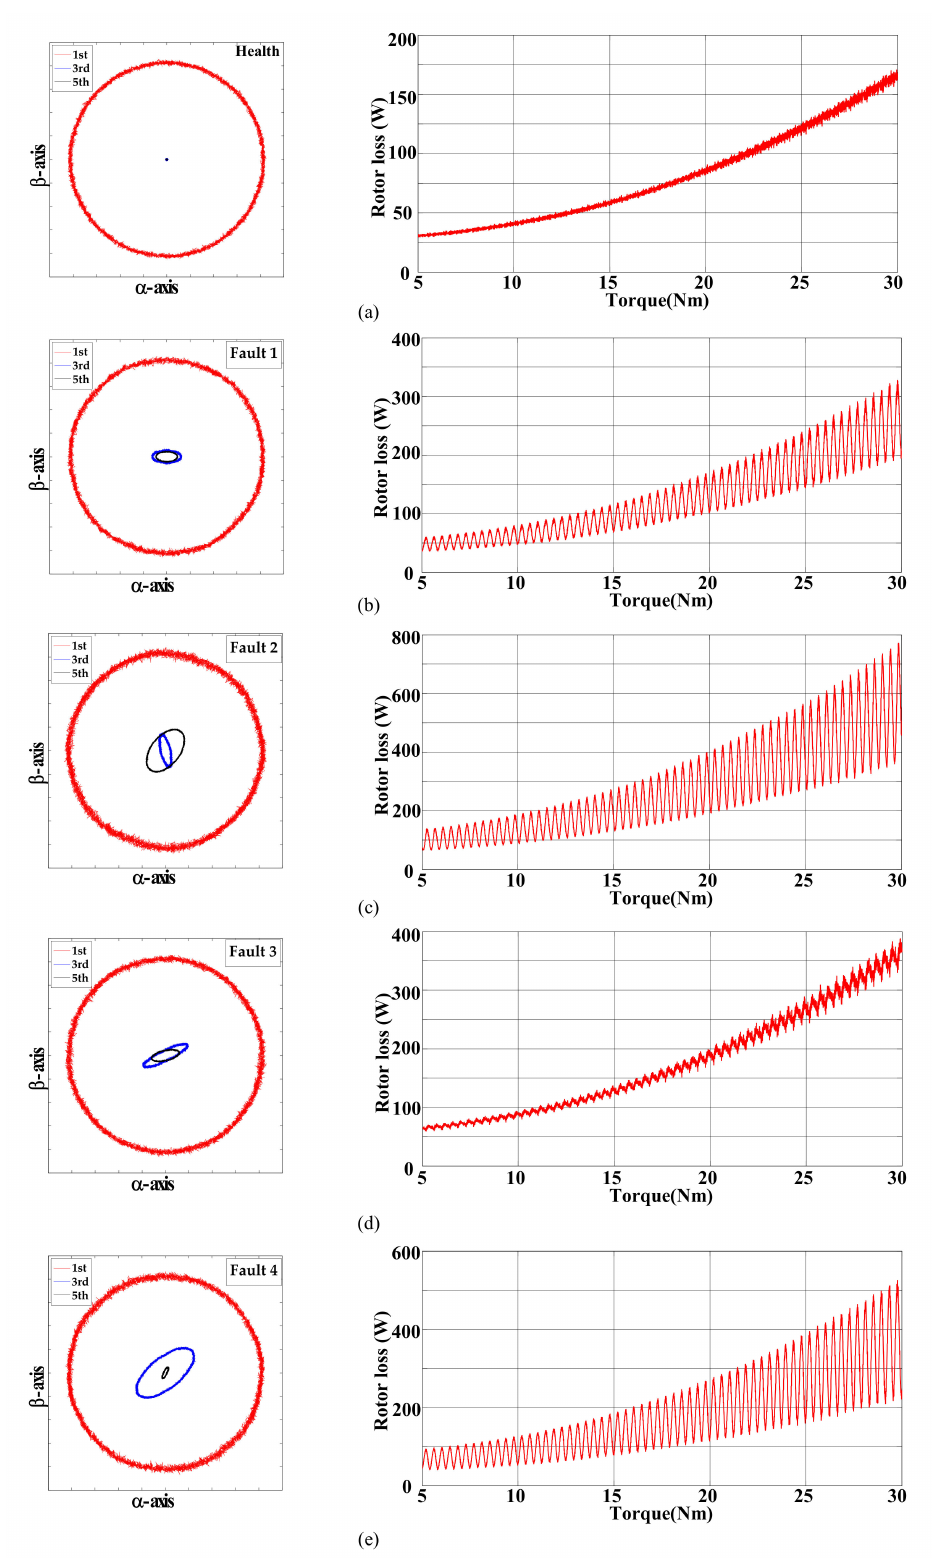
Figure 8. Trajectories of spatial MMF vectors for fundamental and harmonic planes. ( a ) Health, ( b ) Fault 1, ( c ) Fault 2, ( d ) Fault 3 and ( e ) Fault